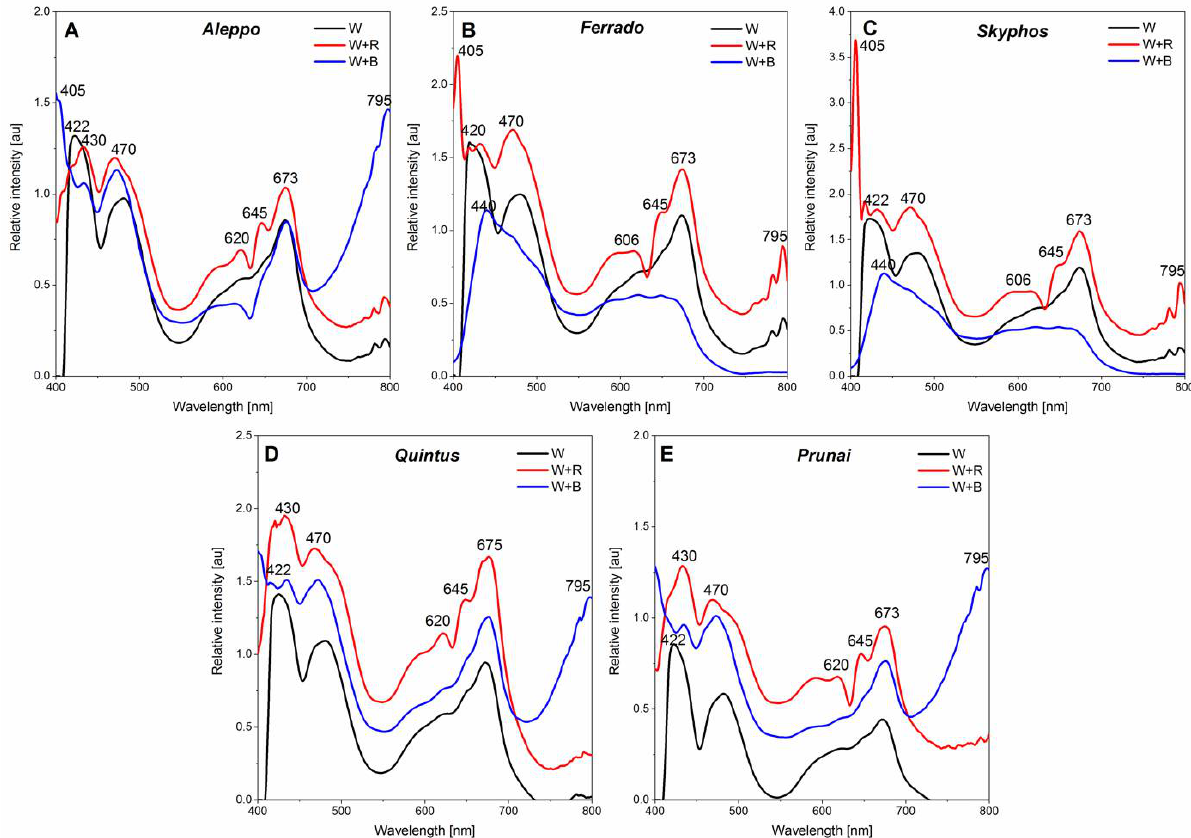
Figure 6. The absorption spectra of leaves of different lettuce cultivars (Aleppo ( A ), Ferrado ( B ), Skyphos ( C ), Quintus ( D ), Prunai ( E )) vs. the spectral composition of light (W—white light, W + R—white and red light, W + B—white and blue light).